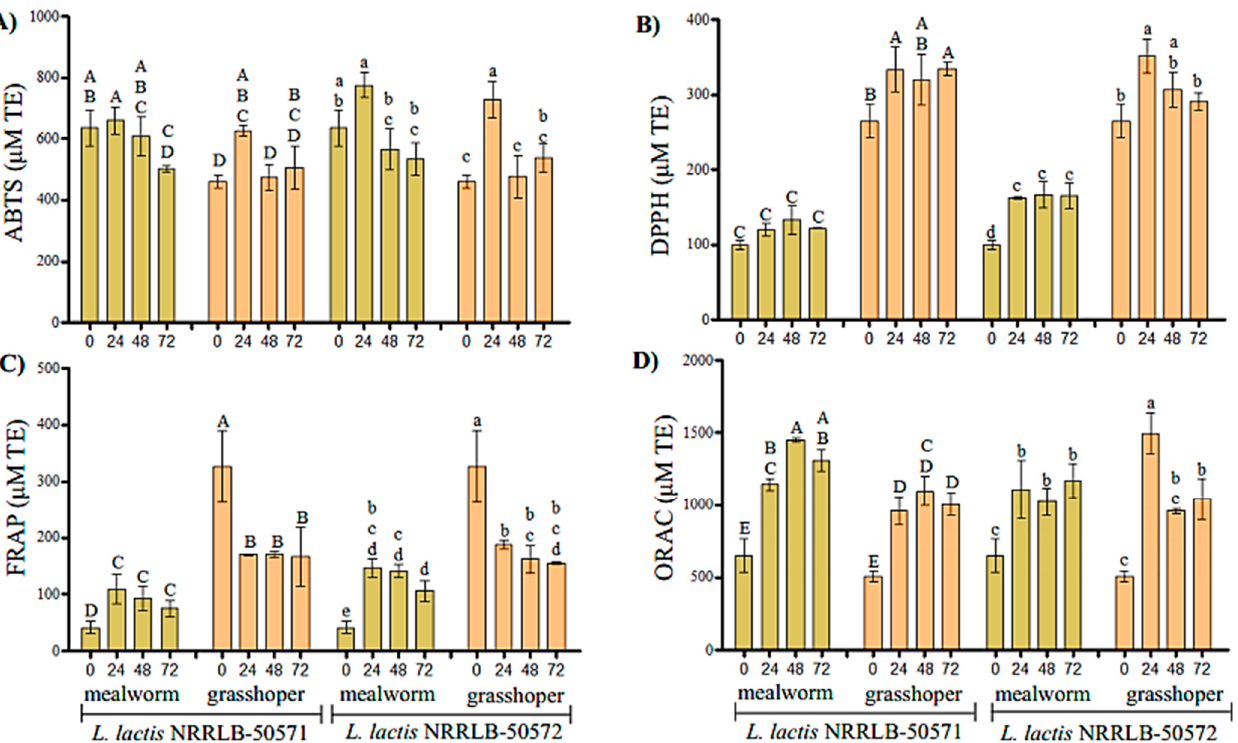
Figure 2. The antioxidant activity ( μ M TE/mL) of the <3 kDa fractions obtained from the two insect flours fermented at 0, 24, 48, and 72 h. TEAC ( A ), DPPH ( B ), FRAP ( C ), and ORAC ( D ). The values shown are the means ± standard deviation ( n = 3). Upper case letters (A–D) show a difference ( p < 0.05) among insects fermented with NRRL B-50571; lower case letters (a–d) show a difference ( p < 0.05) among insects fermented with NRRL B-50572. Table 5. Values of ACEI activity for samples fermented by L. lactis